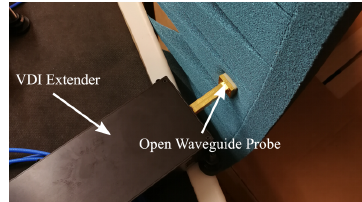
Figure 5. Open waveguide measurement setup of RF